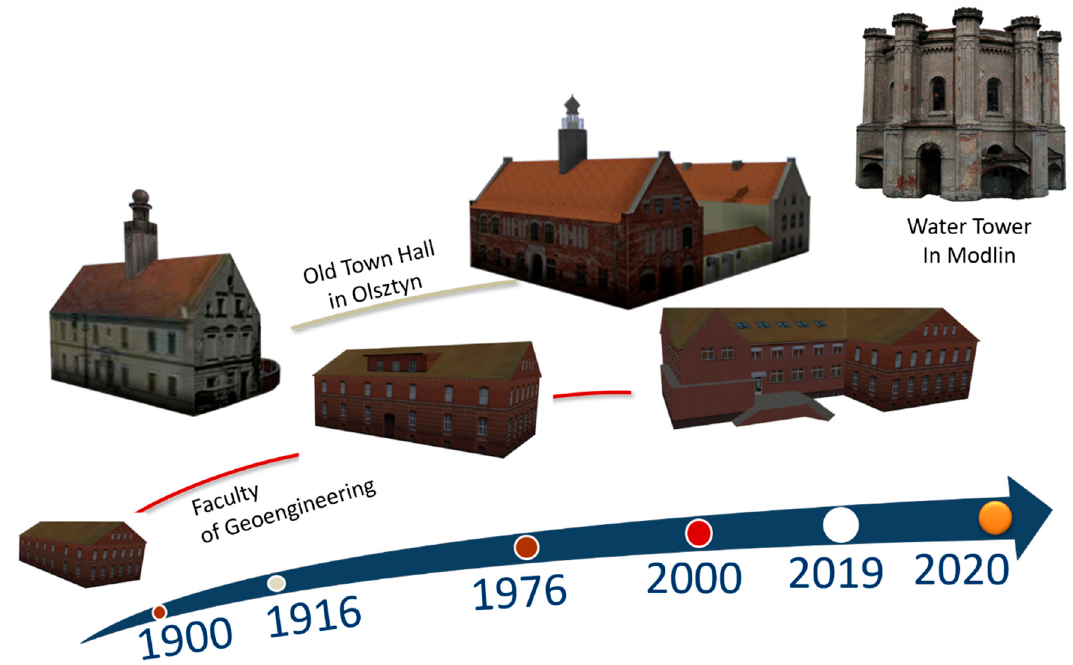
Figure 14. Concept of architecture that allow one to visualize temporary changes of the building façade based on the Water Town in Modlin (top), the Old Town Hall in Olsztyn (middle), main building of the Faculty of Geodesy, Geoengineering (bottom).